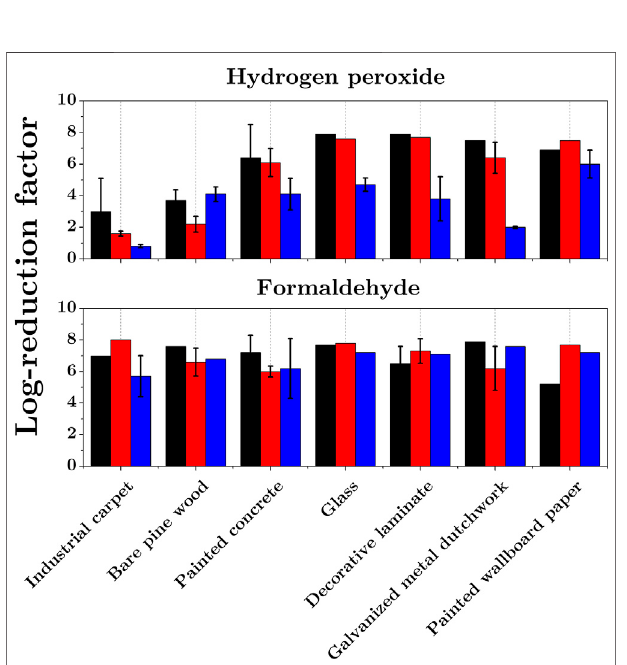
FIGURE4| Effectofexposuretodrygaseousozone(4000ppm,60min, RH < 2 %) on the inactivation of B. Atrophaeus endospores dried on pyrex glass and polymeric surfaces ( top , modi fi ed from [36]), and permeability coef fi cients (units: 10 -13 cm 3 .cm.cm -2 .s -1 .Pa -1 ) of treated materials ( bottom , data taken from